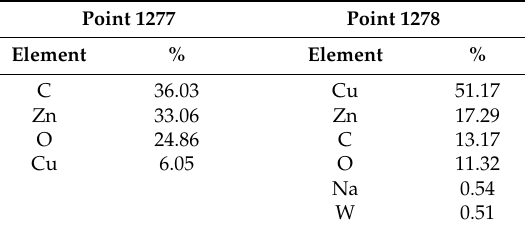
Figure 18. Spectra analyzed in the points of Figure 17. Table 13. Mass of chemical elements at the points analyzed in Figure 17.